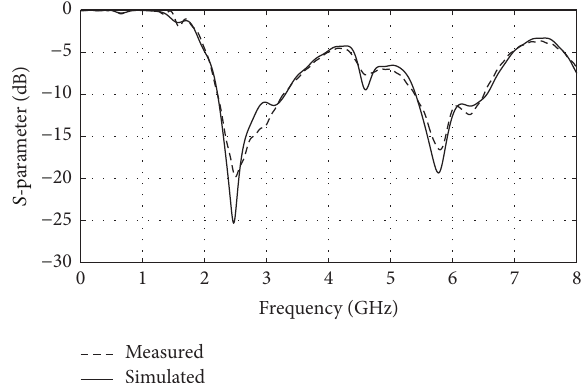
Simulated1 Measured Figure 5: Simulated and measured return loss of antenna